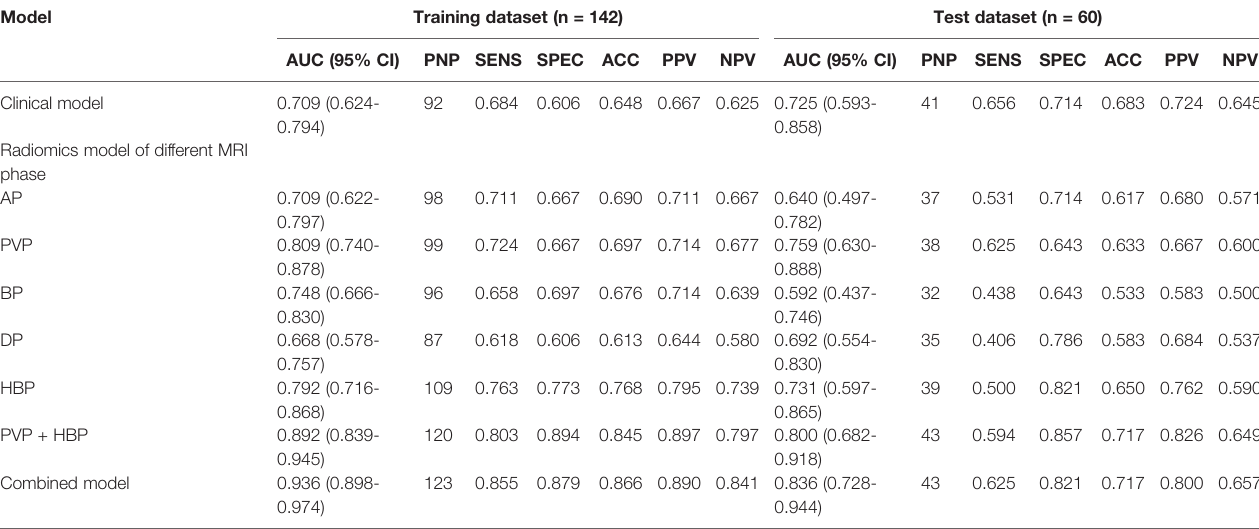
TABLE 3 | Forecasting results of the clinical model, radiomics model and the combined model.